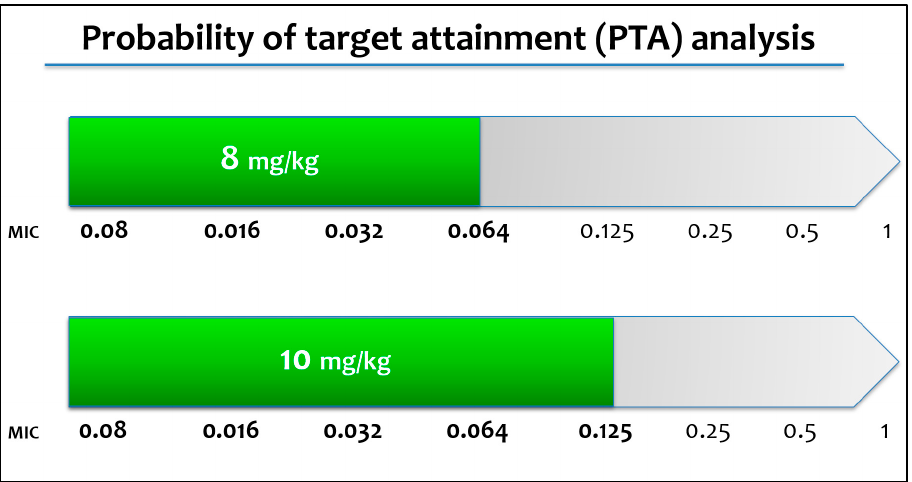
Figure 2. Probability of target attainment calculated for different dosing regimens via Monte Carlo analysis.